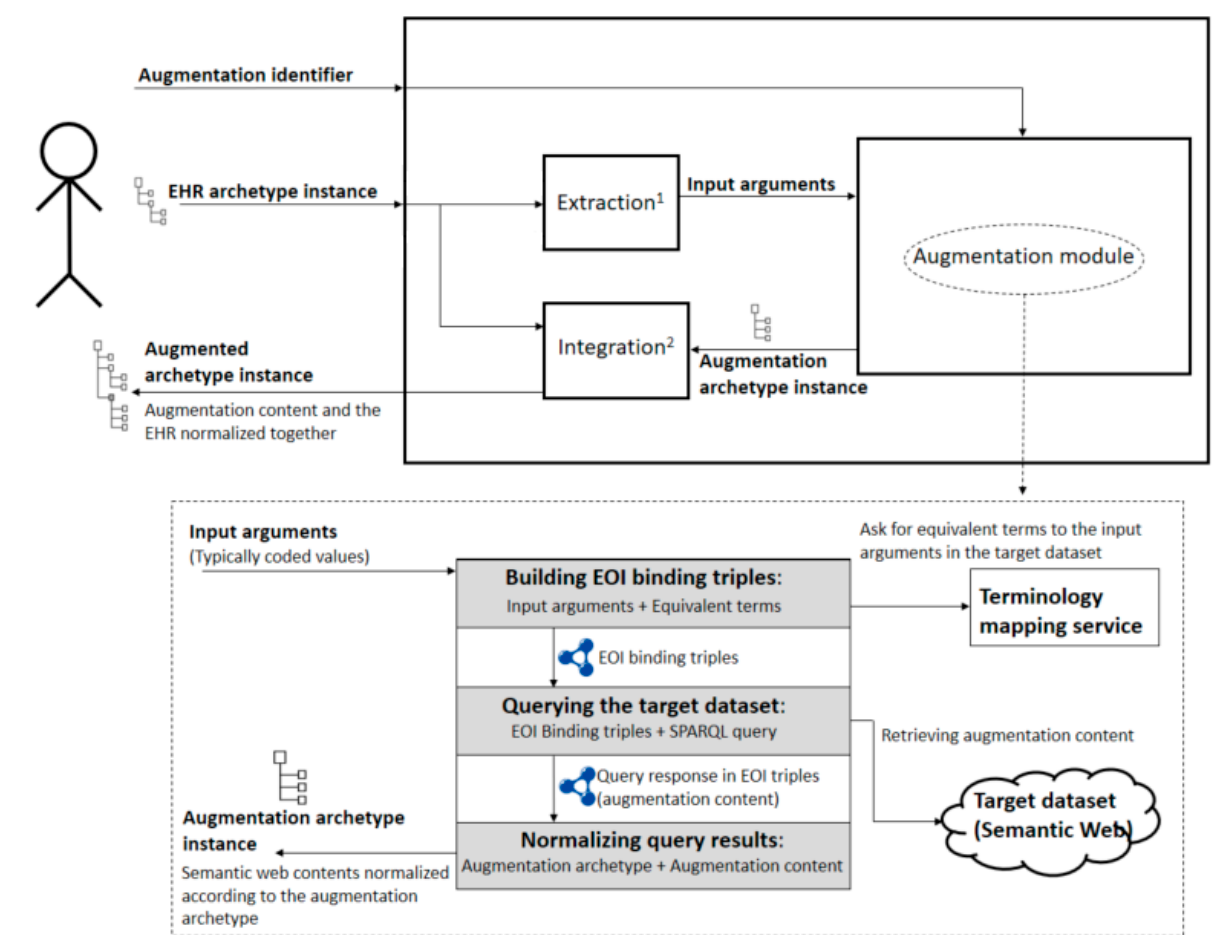
Figure 9. Description of the process to obtain an augmented EHR extract (i.e., execution cycle of the augmented EHR). 1. Extraction : Reads the EOIs specified by paths and provides them to the Augmentation module. 2. Integration : Generates instances of the augmented archetype by combining the EHR archetype instance and the augmentation archetype instance.